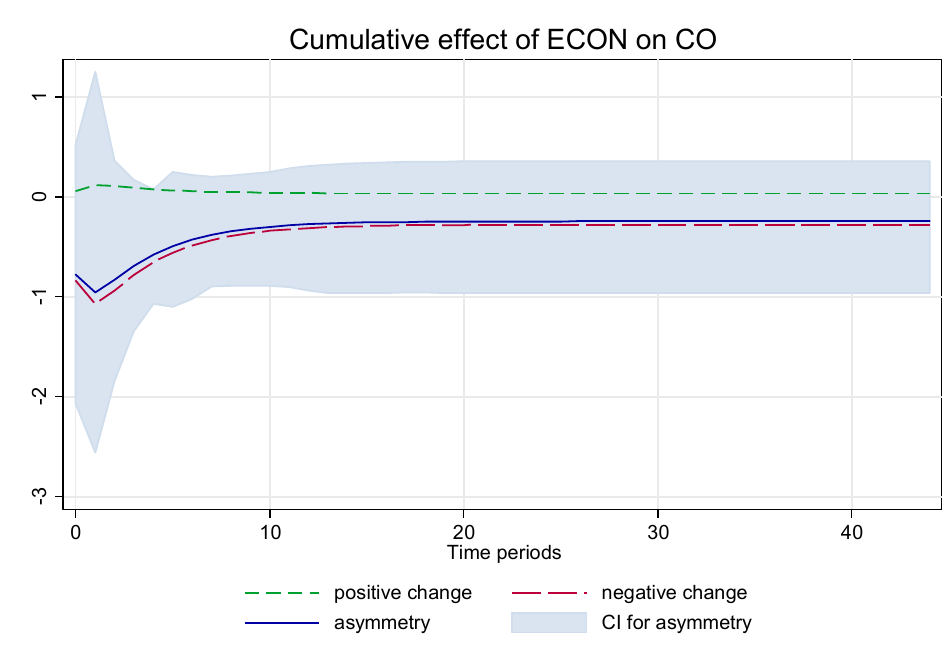
Figure A5. Cumulative effect of ECON on CO.